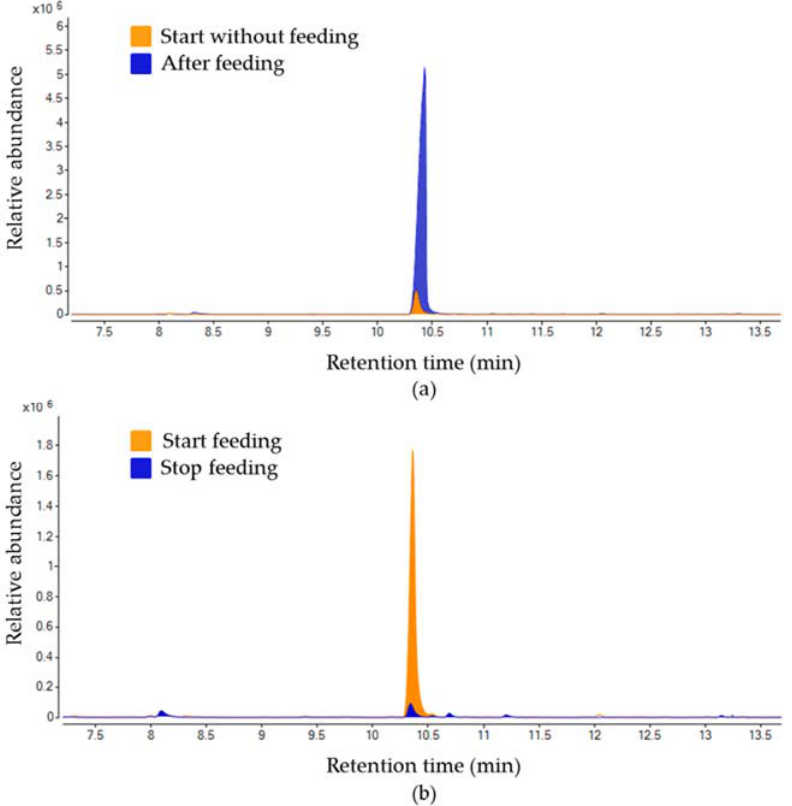
Figure 4. Representative chromatograms of the feeding and starvation effects over the α -terpineol release by Optatus palmaris . ( a ), Increase of the production of α -terpineol after O. palmaris males feed on soursop. ( b ), Decrease of the production of α -terpineol after O. palmaris males stopped feeding on soursop.